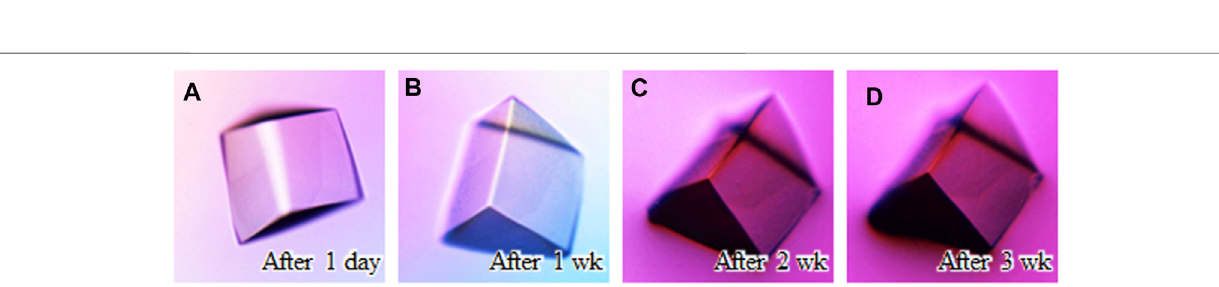
Frontiers in Molecular Biosciences |